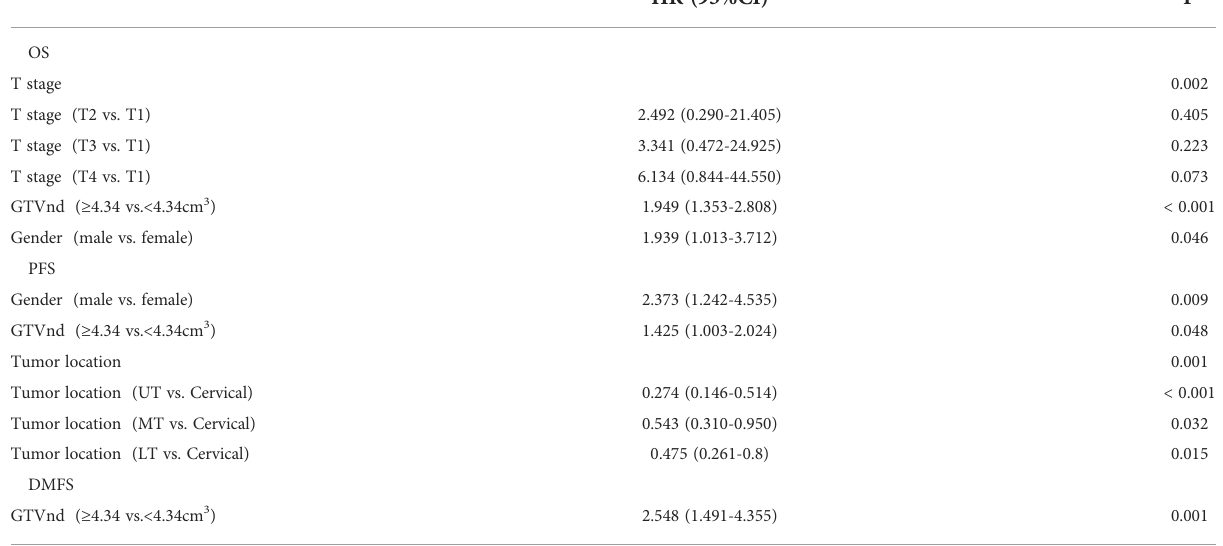
TABLE 3 Multivariate cox proportional hazard regression analysis of prognostic factors in patients with ESCC